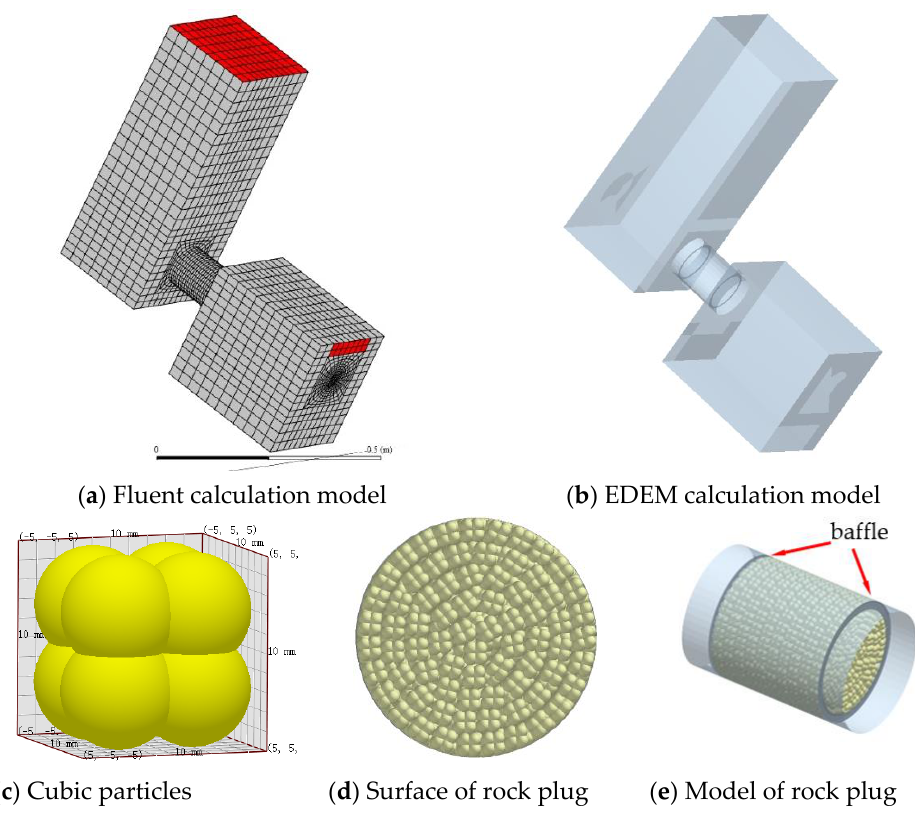
Figure 13. Calculation models for the numerical simulation.